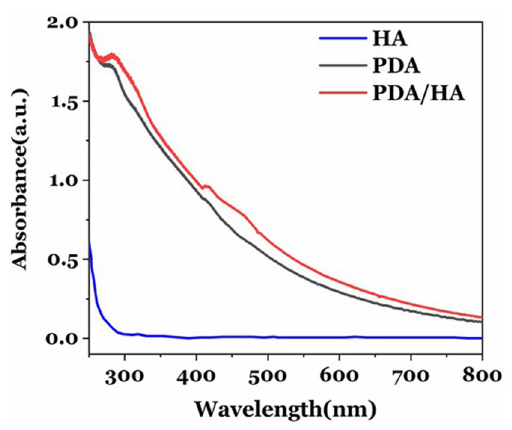
Figure 2. UV–Visible analysis. UV–Visible spectra of synthesized PDA/HA-NPs, PDA-NPs, and